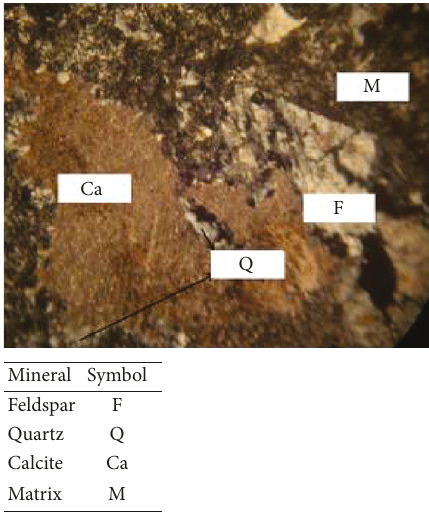
Figure 1: Petrographic microscopic thin section of the rhyodacite tuff